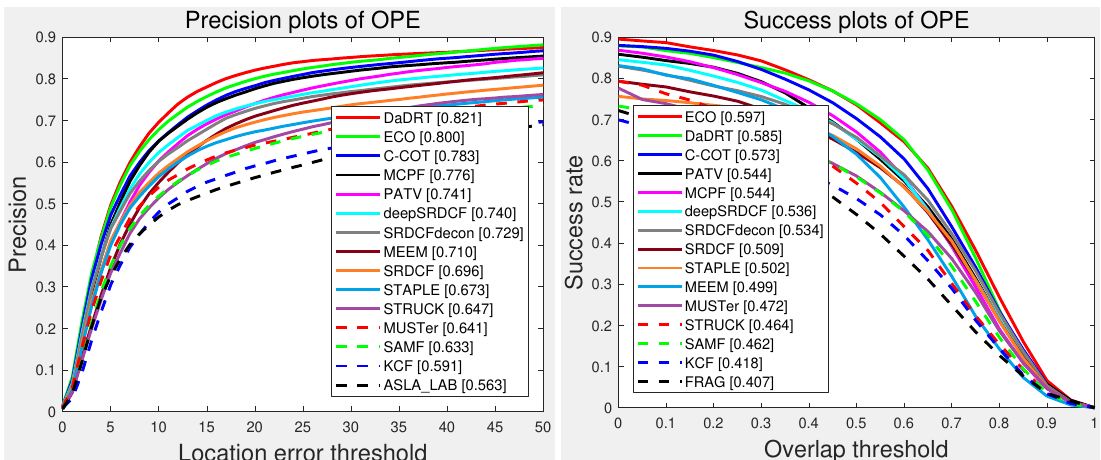
Figure 7. Precision and success plots with the TC-128 dataset using one-pass evaluation. We only show the top 15 performance trackers for representation clarity. Our tracker ranked first in distance precision and second in overlap success. Results are best viewed on high-resolution displays.